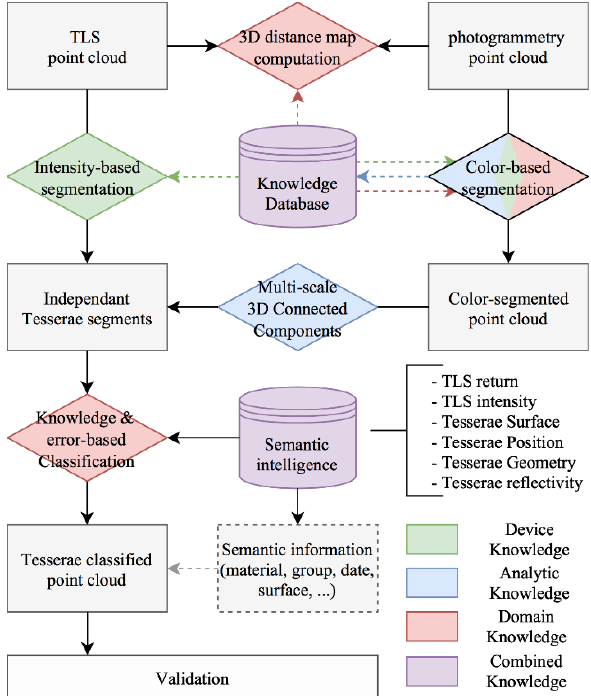
Figure 10 Hybrid segmentation and classification pipeline for an archaeological smart point cloud structuration